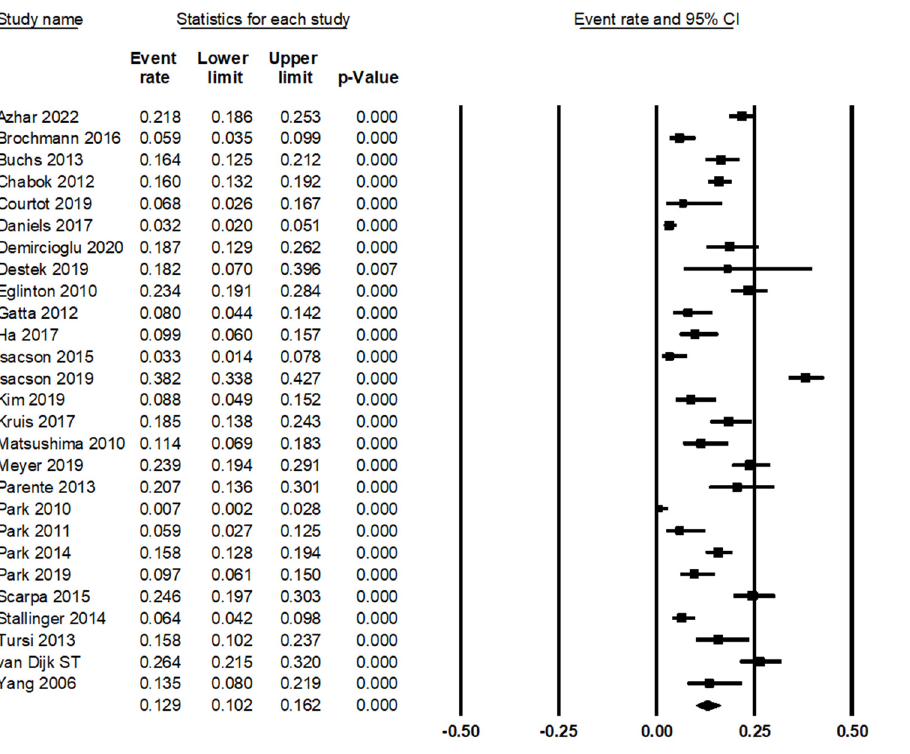
Figure 2. Forest plot for the recurrence rate of uncomplicated diverticulitis.